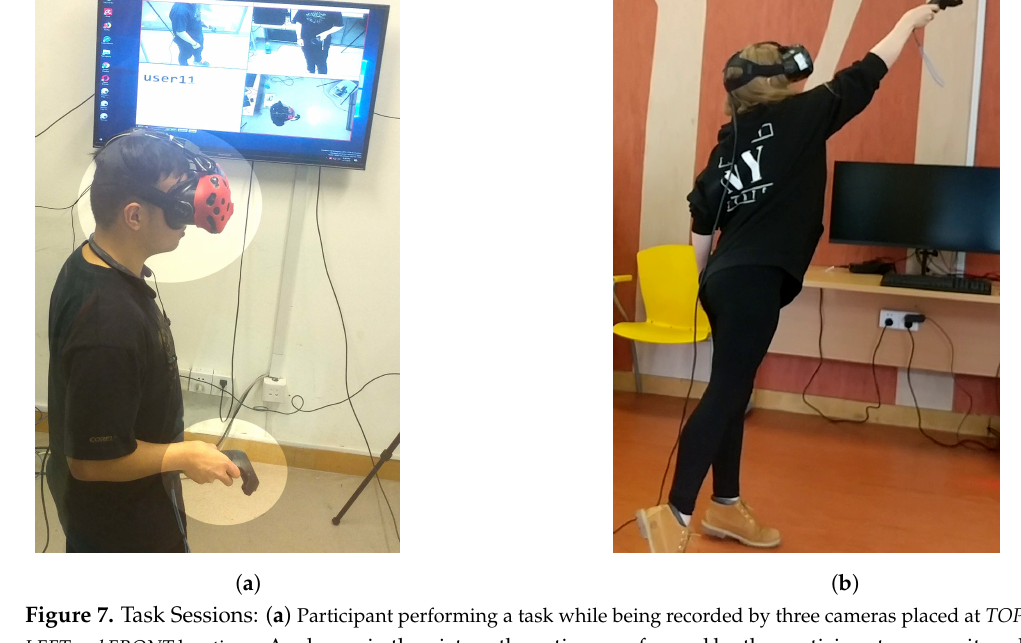
Figure 7. Task Sessions: ( a ) Participant performing a task while being recorded by three cameras placed at TOP, LEFT and FRONT locations . As shown in the picture the actions performed by the participant are monitored and recorded (see TV screen) with emphasis placed on the head and hand movements. This recording is later viewed by an attacker in an attempt to emulate the participant’s movement. ( b ) A participant stretches to maximum height as she performs the task. These kinesiological movements are captured and processed for unique biometric